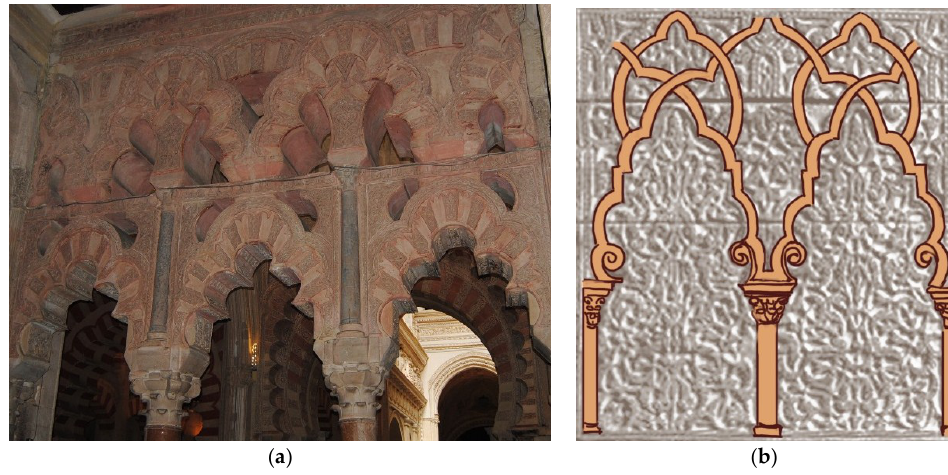
Figure 4. Southern elevation of the Villaviciosa Chapel ( a ). Photo took by author. Drawing of the decoration detail of the minbar of the Kutubiyya Mosque ( b ). Drawing made by author. Arts 2018 , 7 , x FOR PEER REVIEW